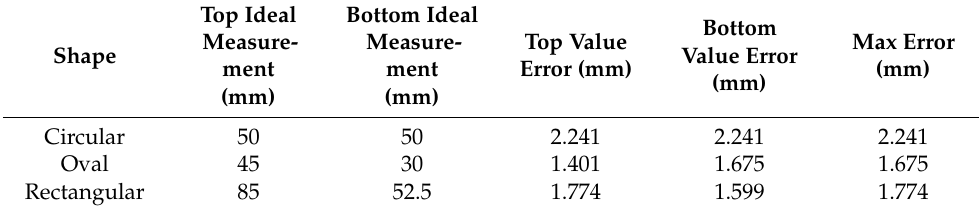
Table 3. Maximum average error for distance to center calculation.